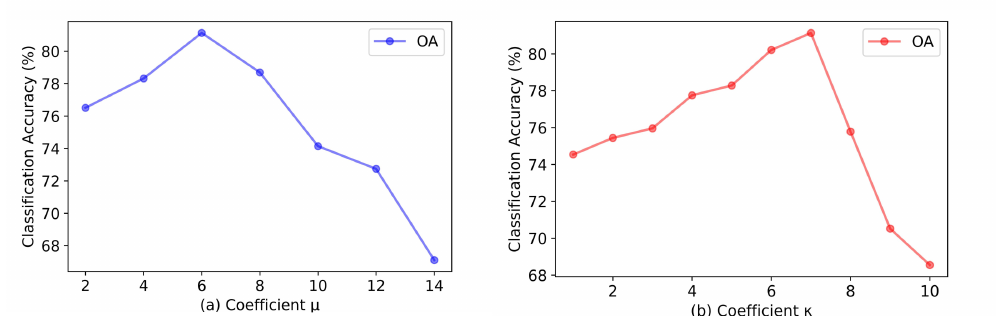
Figure 8. The effects of spectral feature shift and masked bands reconstruction auxiliary task under different hyper-parameter choices on the Indian Pines